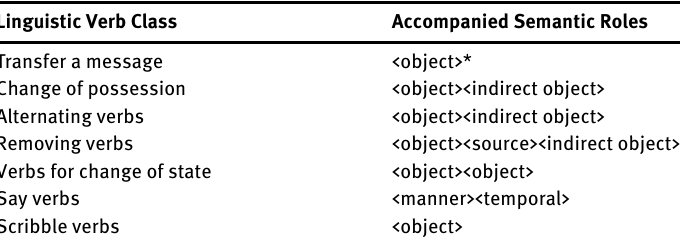
Table 4: Class of a Verb and its Accompanying Semantic Roles. Linguistic Verb Class